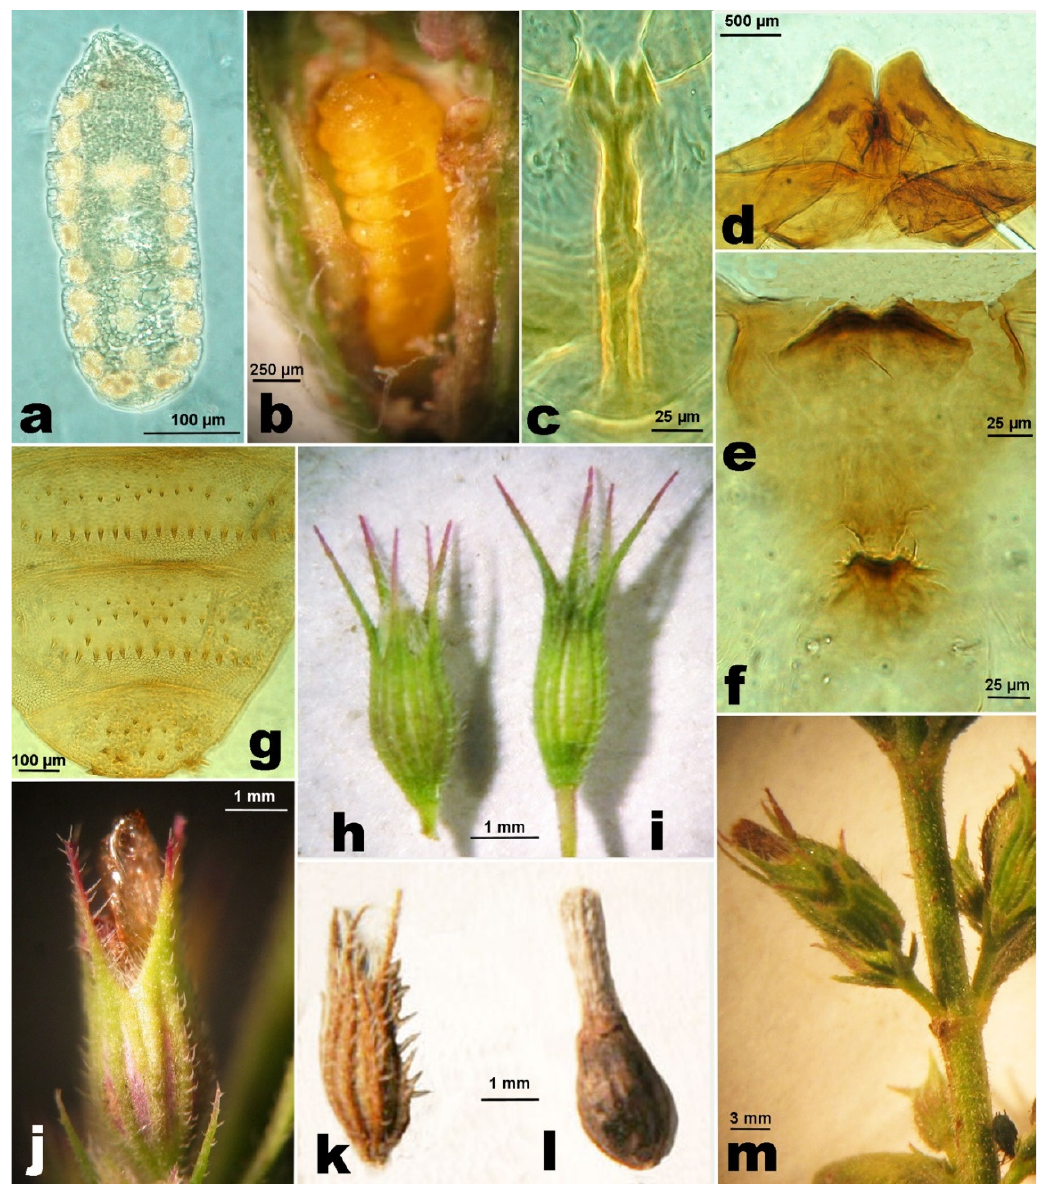
Figure 6. Asphondylia micromeriae . ( a ) . First instar larva. ( b ) . Last instar larva in a gall. ( c ) . Spatula of the same. ( d ) . Pupa, antennal horns. ( e ) . Pupa, upper frontal horns. ( f ) . Pupa, lower frontal horns. ( g ) . Pupa dorsal last segments. ( h ) . Uninfested flower. ( i ) . Infested flower. ( j ) . Flower gall with the pupal case of the emerged midge. ( k ) . Calyx of a flower gall. ( l ) . True gall. ( m ) . Stem with flower galls.